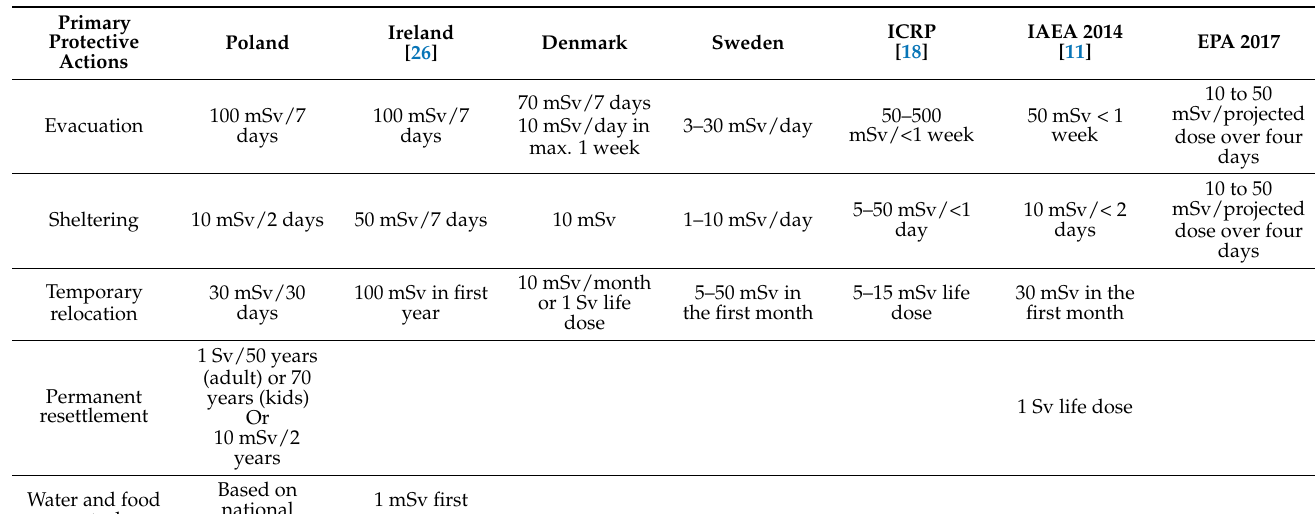
Table 5. Intervention levels (IL) of avertable dose for the population